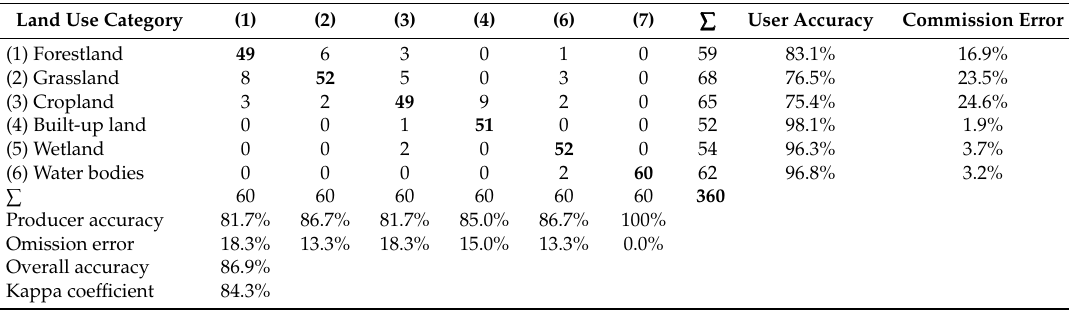
Table 2. Error Matrix for land cover and land use map (Figure 5d) of Rwanda 2016.